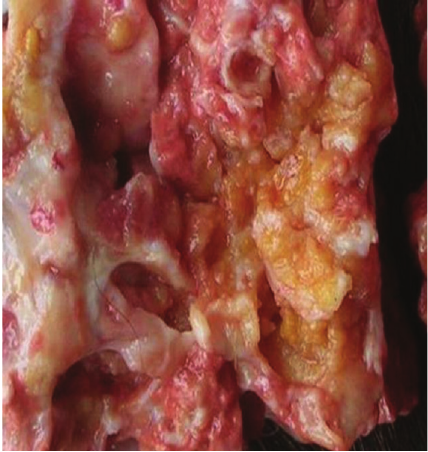
Figure 2: Postmortem examination. Adenocarcinoma metastasis— Two to five centimetres nodules in lung posterior dorsal lobe showing on cut yellow surface.